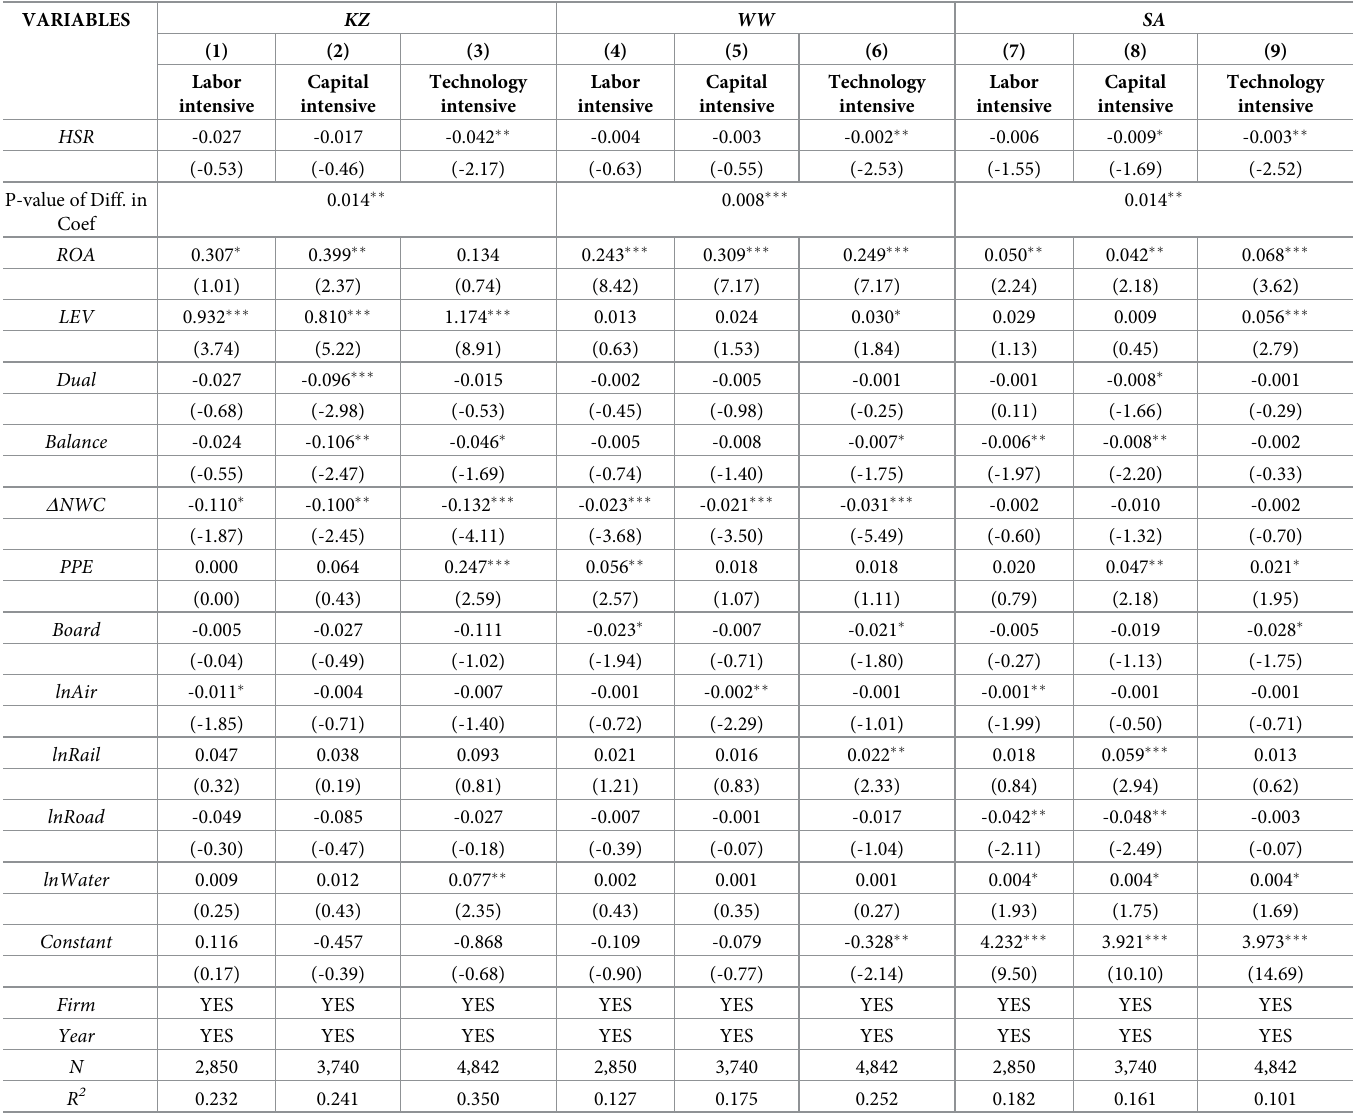
Table 5. Regression results for different